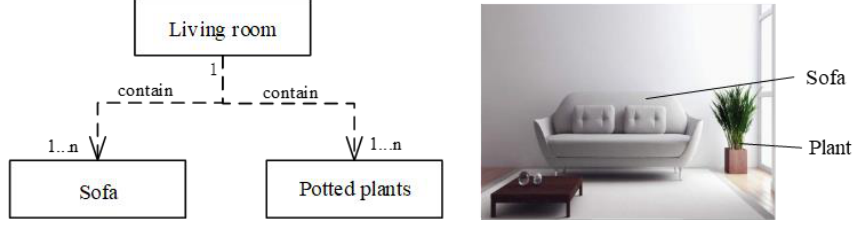
Figure 9. Containment relationship diagram.